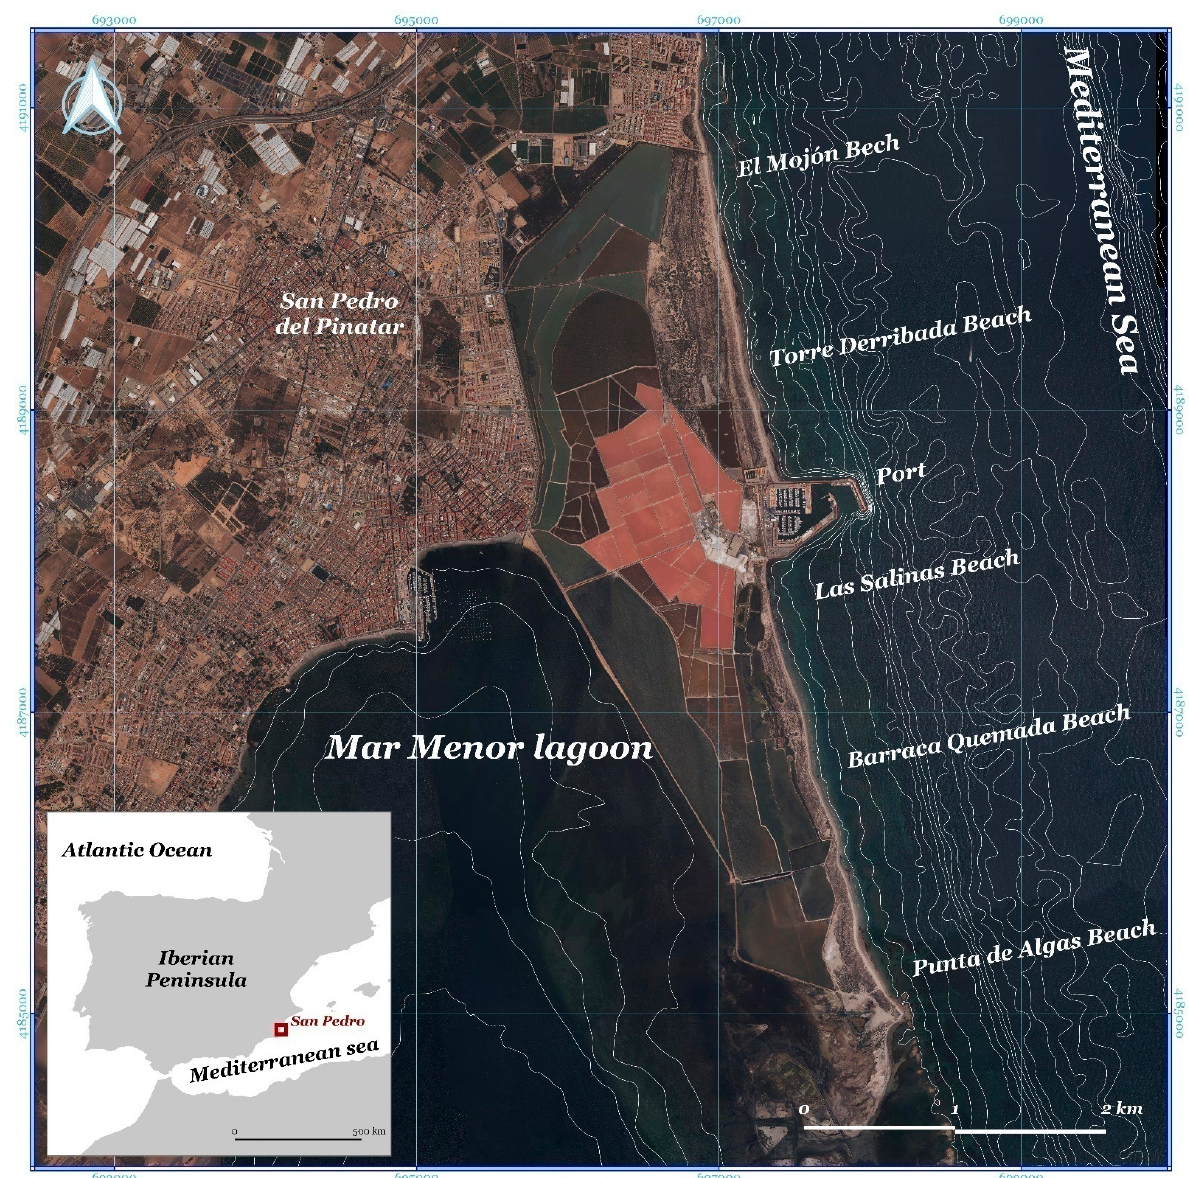
Figure 1. Regional Park of Salinas and Arenales of San Pedro Del Pinatar Beaches. Source: own elaboration.